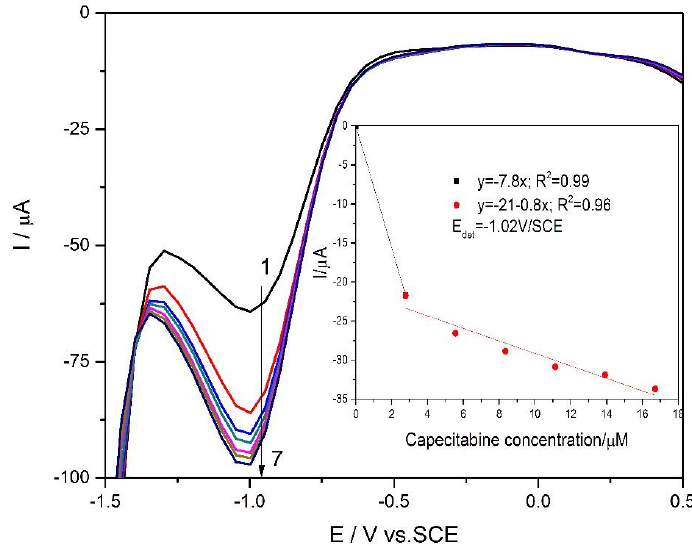
Figure 10. Di ff erential-pulsed voltammograms recorded at LaFeO 3 / BDD electrode in 0.1 M NaOH Figure 10. Differential-pulsed voltammograms recorded at LaFeO 3 /BDD electrode in 0.1 M NaOH (curve 1) and in the various CCB concentrations ranged from 2.5 µM to 17 µM (curves 2-7), scan rate (curve 1) and in the various CCB concentrations ranged from 2.5 µ M to 17 µ M (curves 2–7), scan rate of of 0.05 Vs −1 , modulation amplitude of 0.2 V, and step potential of 0.05 V. 0.05 Vs − 1 , modulation amplitude of 0.2 V, and step potential of 0.05 V.